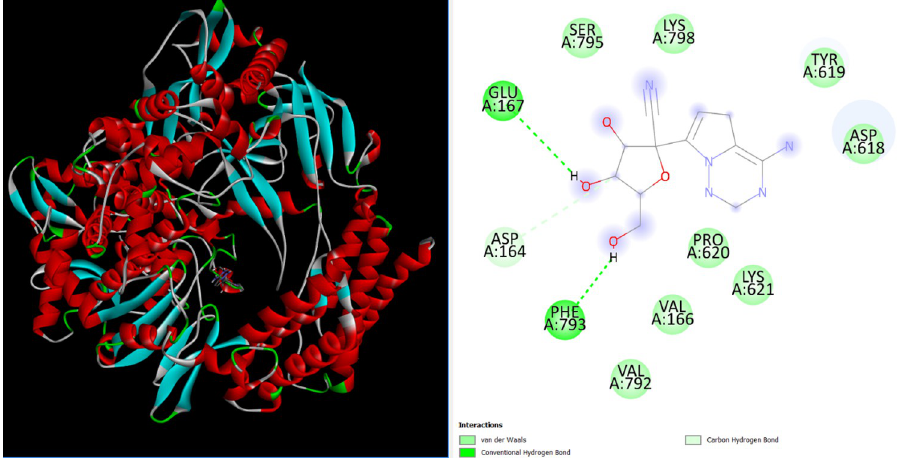
Fig 4. Binding conformation. Interactions of control molecule with the